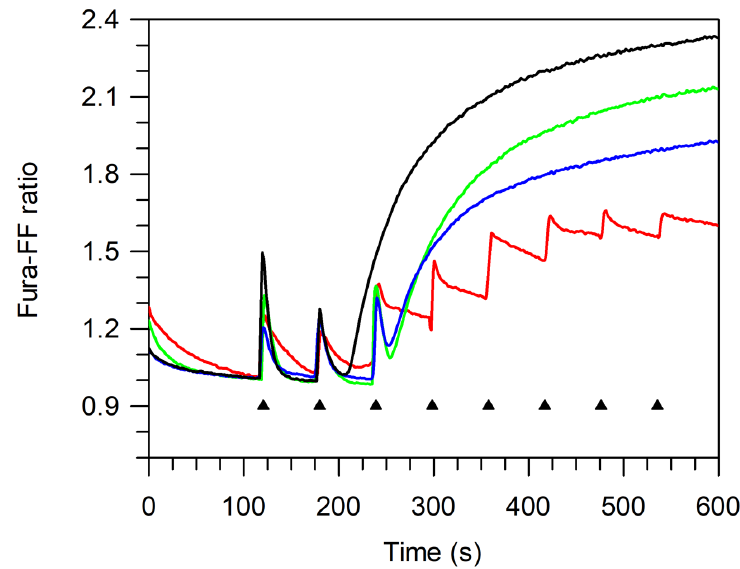
Figure 3. Evaluation of mPTP opening. Representative curves of at least three different experiments on the calcium retention capacity (CRC). The CRC was monitored in response to subsequent 10 µ M CaCl 2 pulses (shown by the triangles), as detailed in Section 2.6, in the absence (control—black line) ( − ) and in the presence of the inhibitors 2 mM MgADP (red line) ( − ), 50 µ g/mL BPF (green line) ( − ), and 100 µ g/mL BPF (blue line) ( −